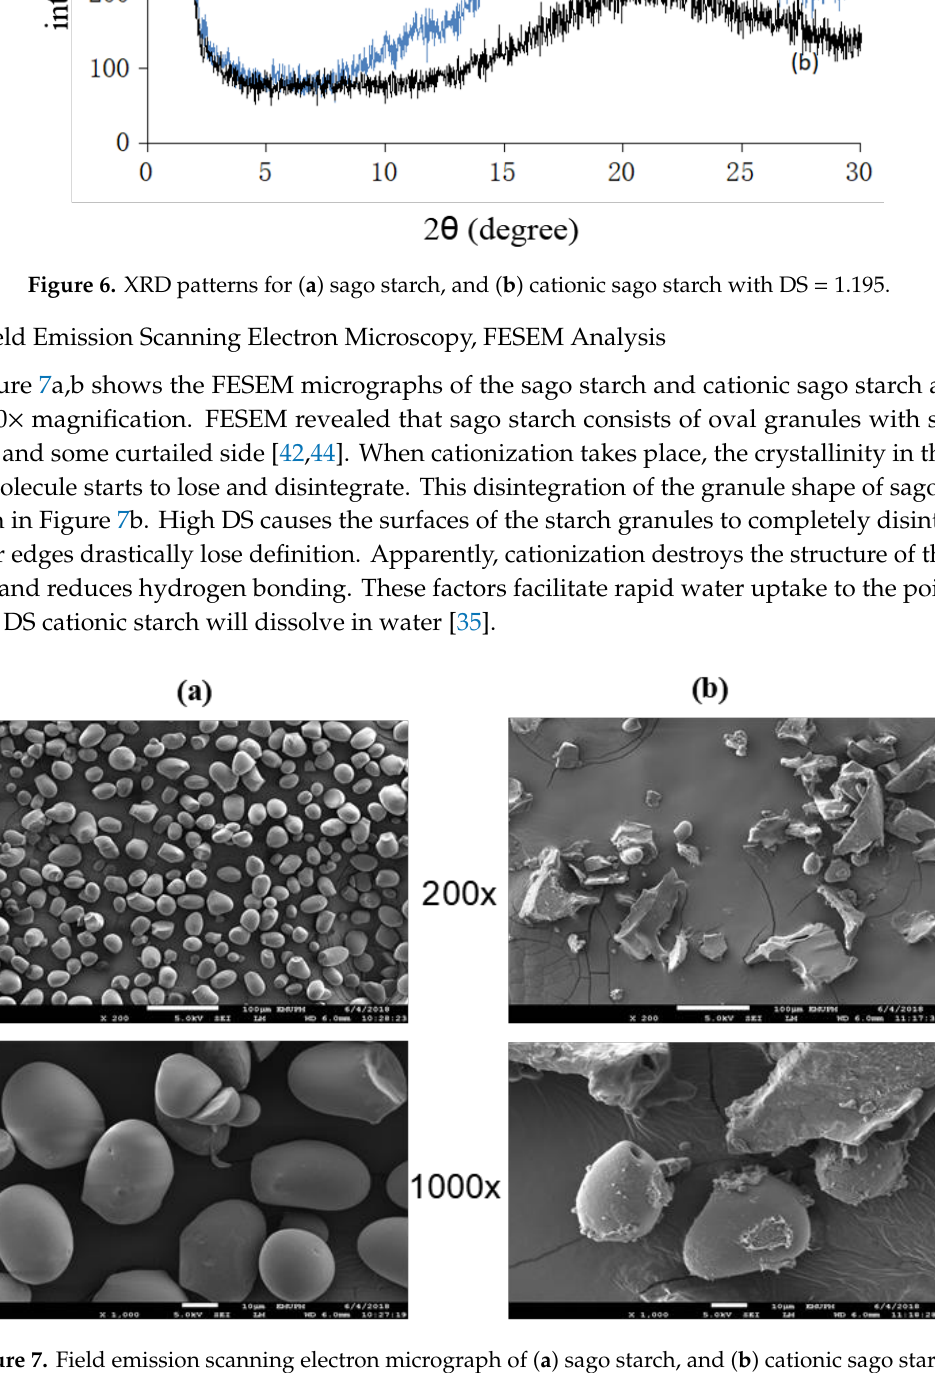
Figure 7. Field emission scanning electron micrograph of ( a ) sago starch, and ( b ) cationic sago starch with DS 1.195 at ×200 and ×1000 magnification.